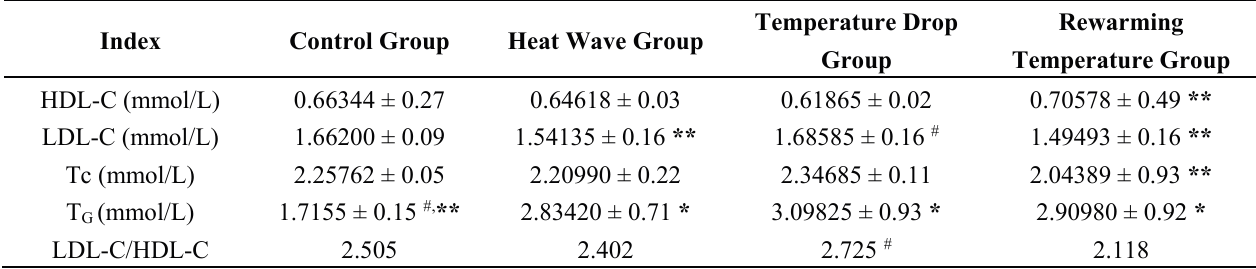
Table 3. Comparison of HDL-C, LDL-C, TC, and TG levels in ApoE − / −